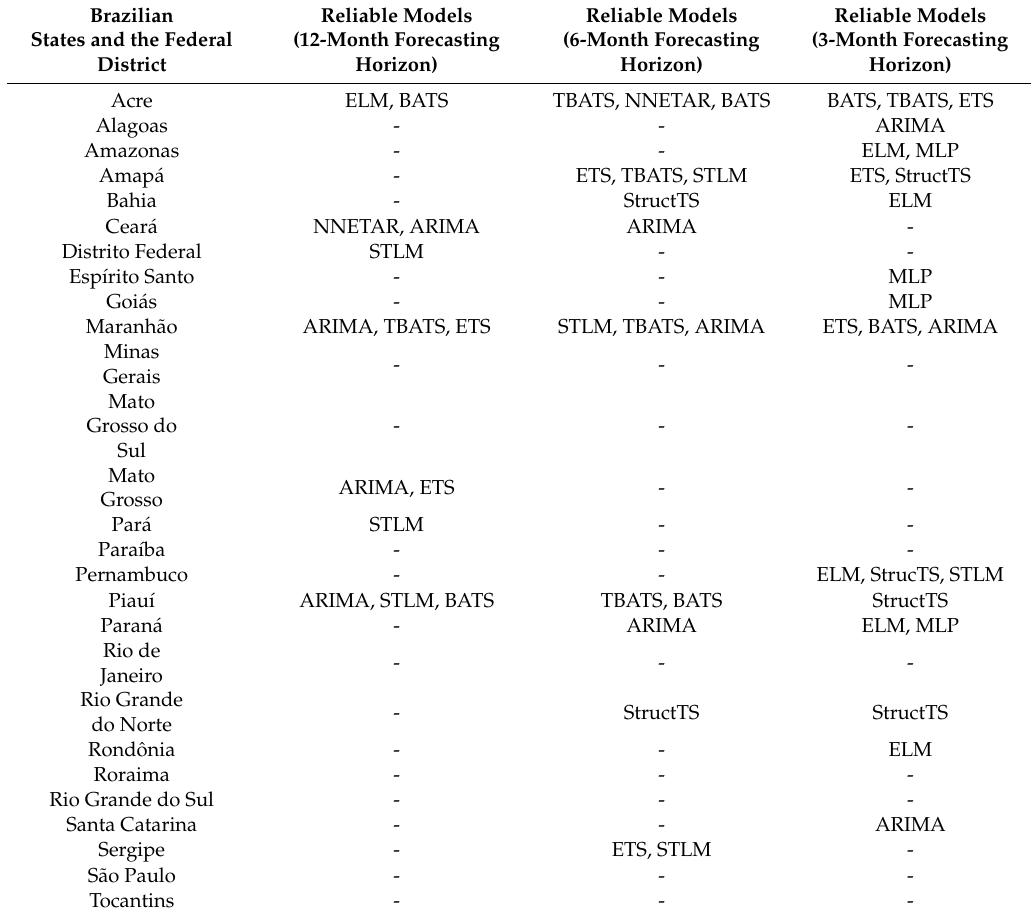
Table 2. Reliable statistical models for predicting dengue cases in three forecasting horizons according to the states and federal district of Brazil from 2000 to